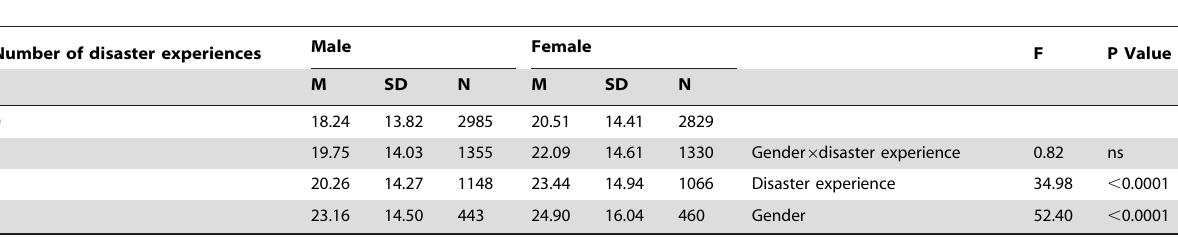
Table 7. Average PTSSC-15 score (number of disaster experiences and gender).